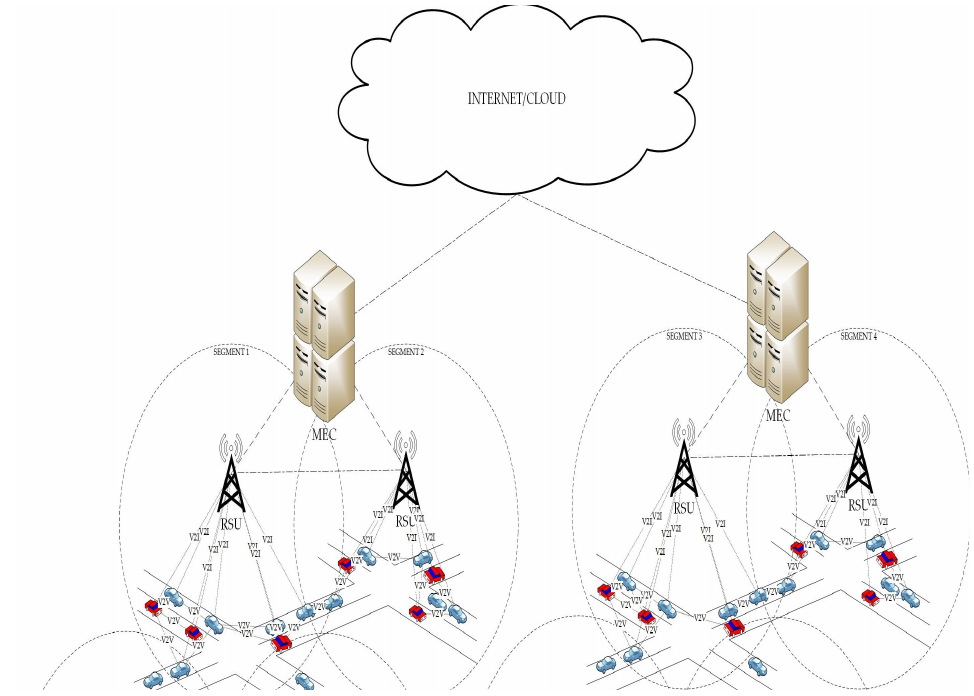
Figure 1. The architecture of the proposed